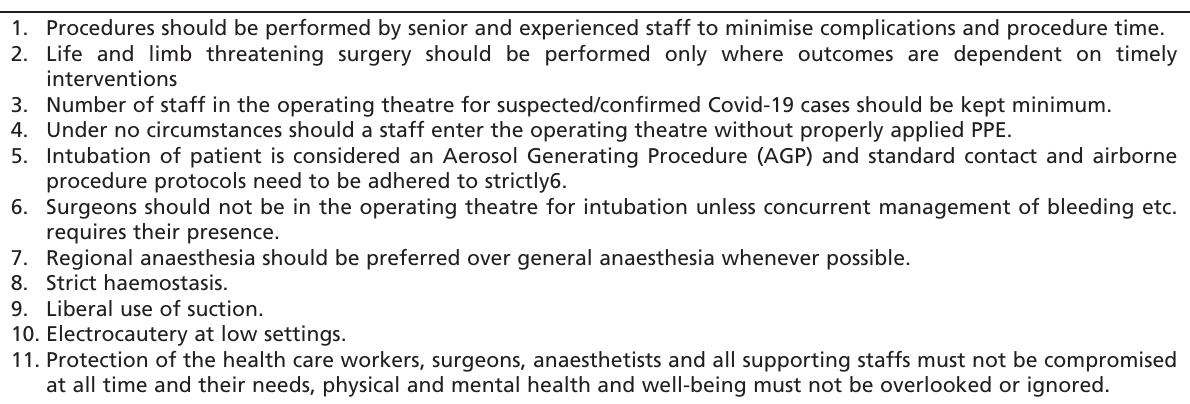
Intraoperative guidelines in managing COVID patients/PUI for the orthopaedic Fig. 3: